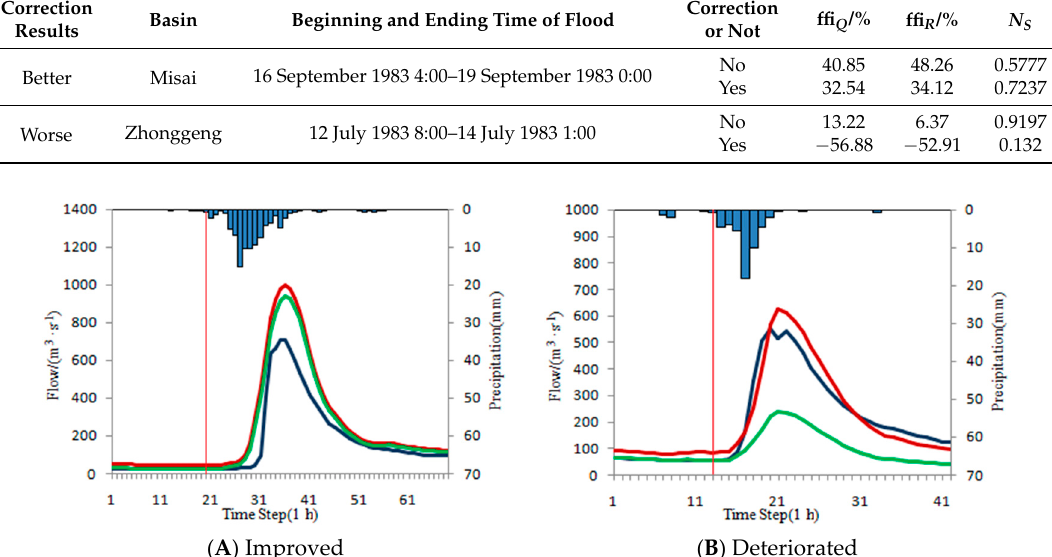
Table 17. Statistics of correction results of complex floods in each basin.